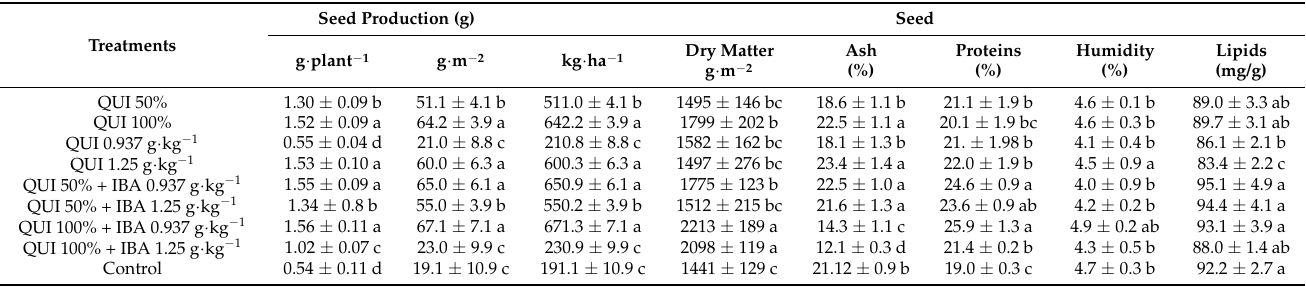
Table 6. Yield and production of biomass (dry matter g · m − 2 ) and effect on the content of lipids, proteins, humidity and ash of the seed of S. bigelovii , produced by cuttings under conditions of the Altar desert, Sonora. Seed Production (g) Seed Treatments g · plant − 1 Humidity (%) Lipids (mg/g) QUI